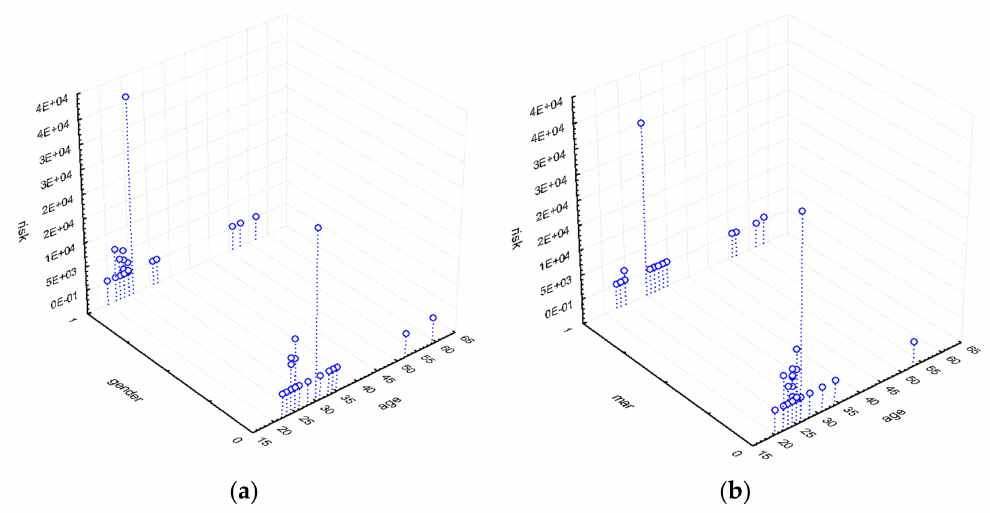
Figure 3. 3D scatter plots by factor groups: age, gender, and risk ( a ) and age, mar, and risk ( b ).